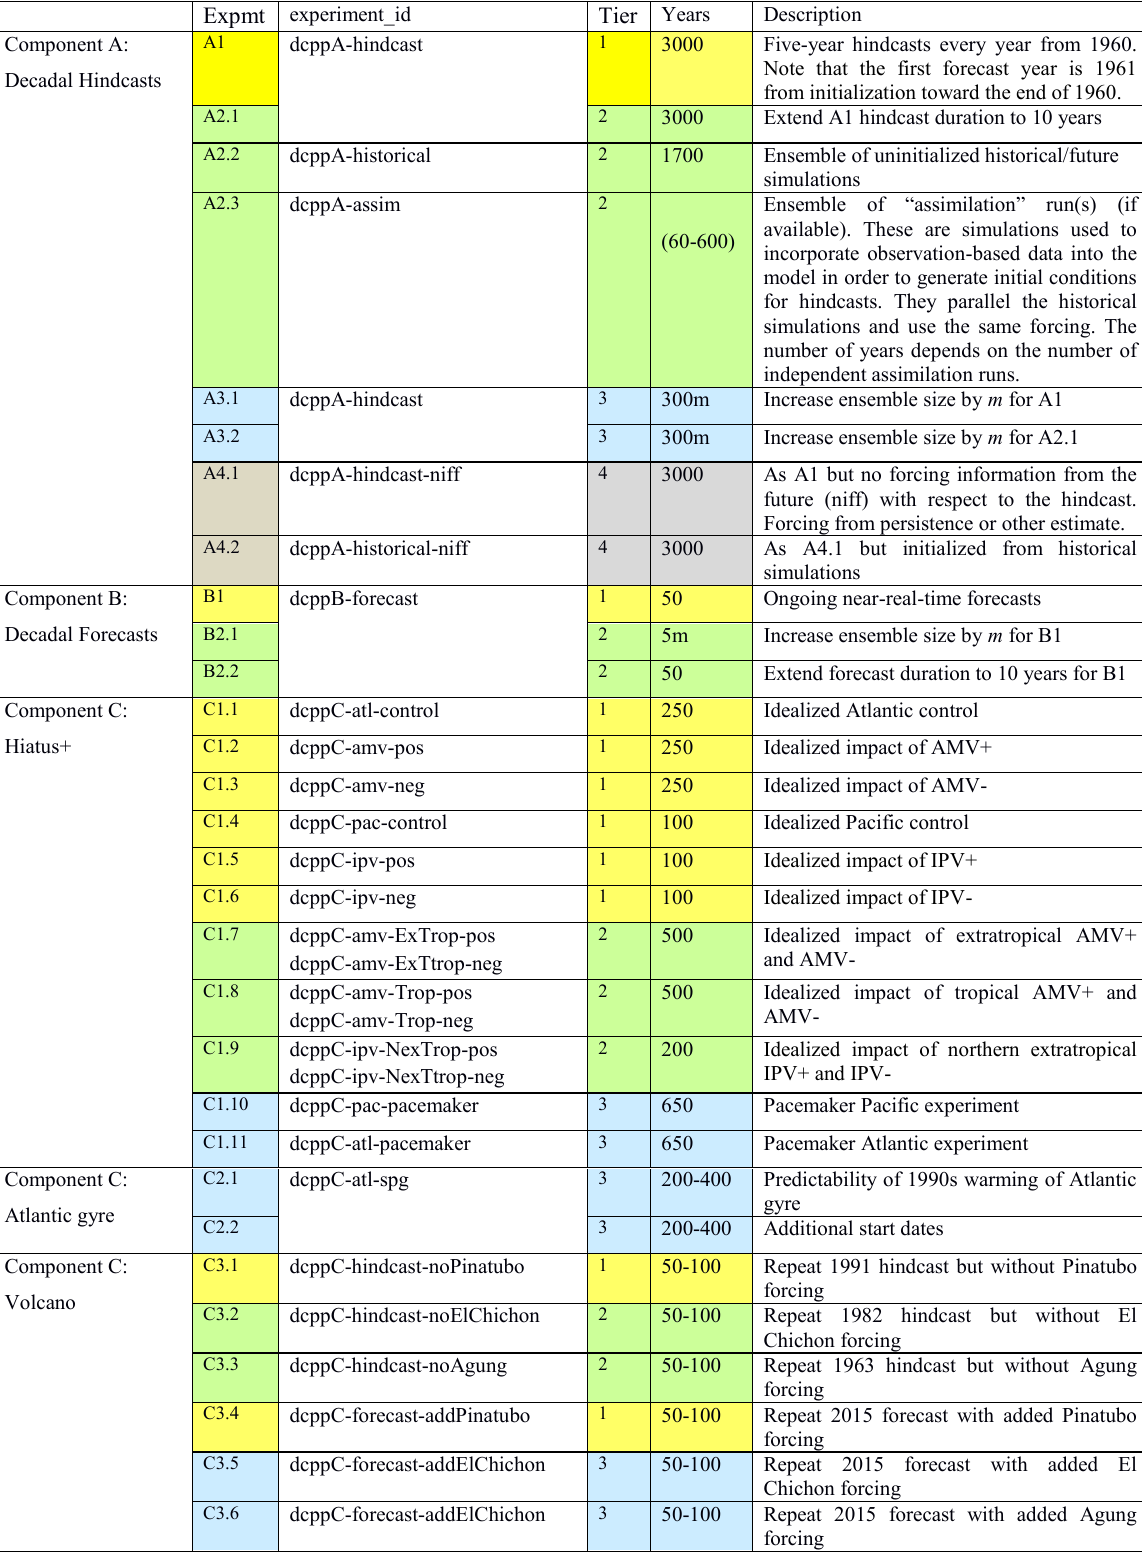
Table 1. DCPP experiments. Table1: DCPP experiments Expmt experiment_id Tier